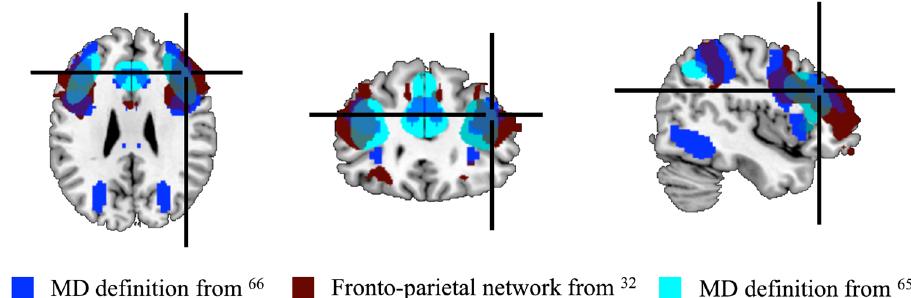
Fig. 2 Reference coordinate for TMS target site in right dlPFC. Functional activation and connectivity maps from previous studies (as in legend) were used to select MNI152 coordinates [44 31 28] as a group-level reference for right dlPFC target (cross hair). After deforming to native space, we de fi ned the target stimulation site on an individual-participant basis using the peak activation from individual-participant functional localiser data that was within 14 mm of this reference point.